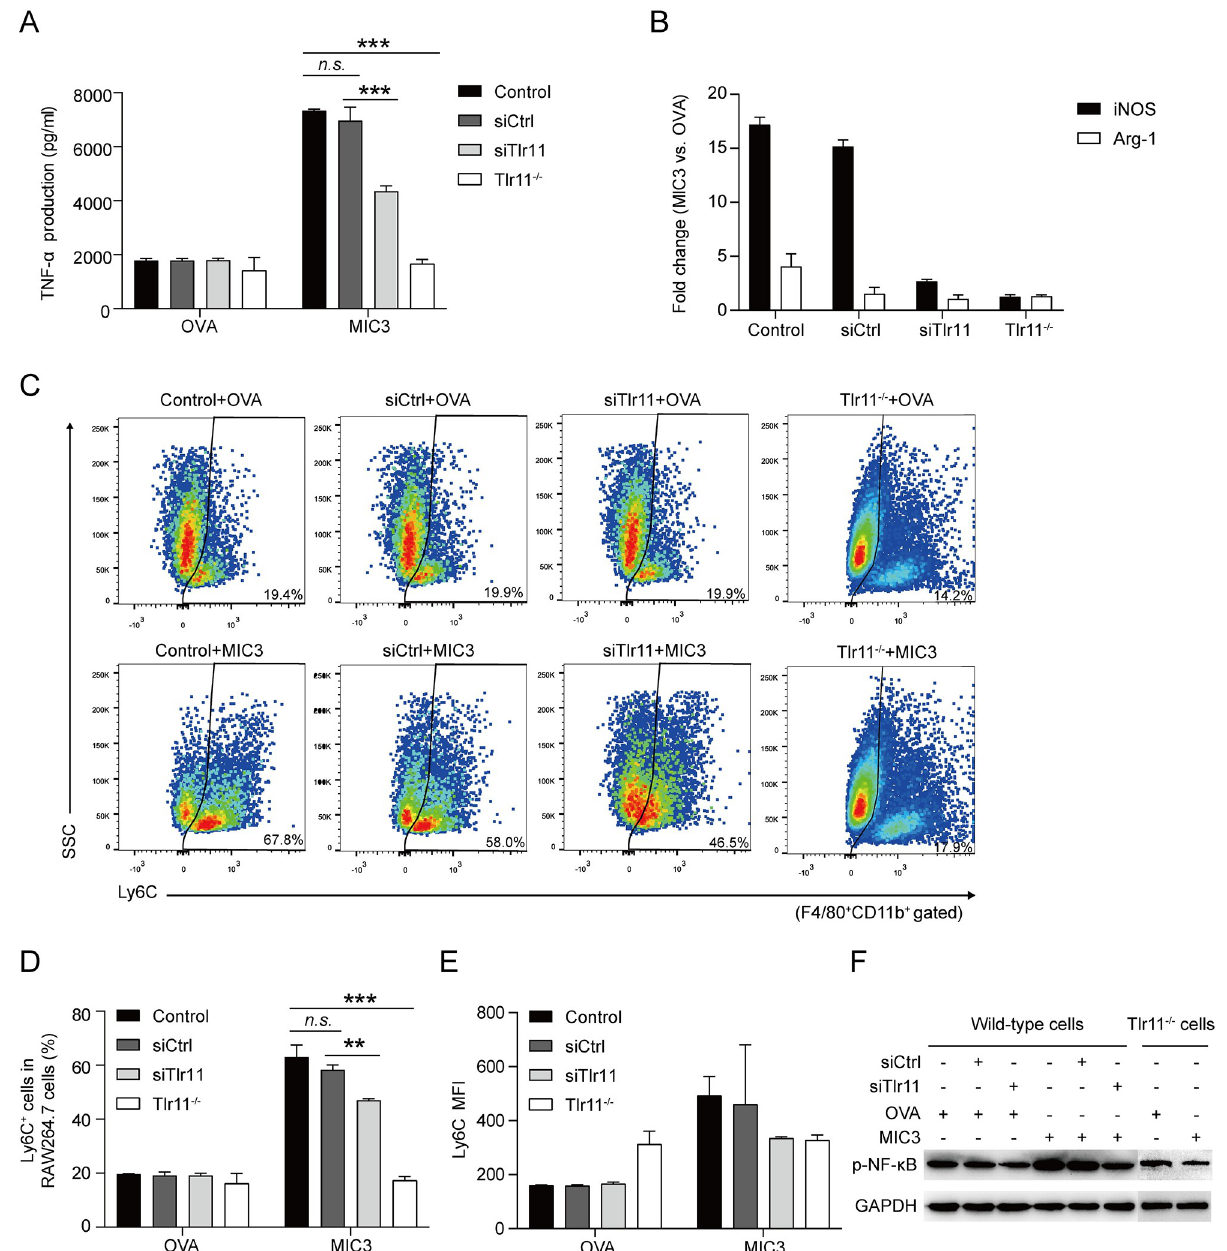
Fig 5. The effects of Tlr11 knock-down and knock-out on MIC3-induced immune responses in RAW264.7 cells. (A) The effects of Tlr11 knock- down and knock-out on TNF- α secretion of RAW264.7 cells after 24 h-treatment of 4 μ g/ml MIC3 or OVA. To knock-down the Tlr11 , siRNA targeting Tlr11 (siTlr11) and a control siRNA (siCtrl) were used. CRISPR/Cas9 technology was used to create a Tlr11 knock-out RAW264.7 cell line ( Tlr11 -/- ). Each bar indicates the mean value ± S.D. (n = 3 independent experiments). Significance was analyzed using one-way ANOVA. ��� , P < 0.001. n . s ., P > 0.05. (B) The effects of Tlr11 knock-down and knock-out on the mRNA levels of polarization-related genes ( iNOS and Arg-1 ) after 24 h- treatment of MIC3 in RAW264.7 cells. Data are expressed as the means ± S.D. (n = 3 independent experiments). 1 = no change. (C) Ly6C expression in Tlr11 knock-down and knock-out RAW264.7 cells. Ly6C expression after 24 h-treatment with 4 μ g/ml OVA and 4 μ g/ml MIC3 were evaluated by flow cytometry. One representative of three independent experiments is shown. (D) The percentage of Ly6C + cells in F4/80 + CD11b + gated RAW264.7 cells. Each bar indicates the mean value ± S.D. (n = 3 independent experiments). Significance was analyzed using one-way ANOVA. ��� , P < 0.001. �� , P < 0.01. n . s ., P > 0.05. (E) The MFI of Ly6C expression in F4/80 + CD11b + gated RAW264.7 cells. Data are expressed as the means ± S.D. (n = 3 independent experiments). (F) The effects of Tlr11 knock-down and knock-out on MIC3-induced NF- κ B p65 phosphorylation. The NF- κ B p65 phosphorylation of RAW264.7 cells was evaluated by Western